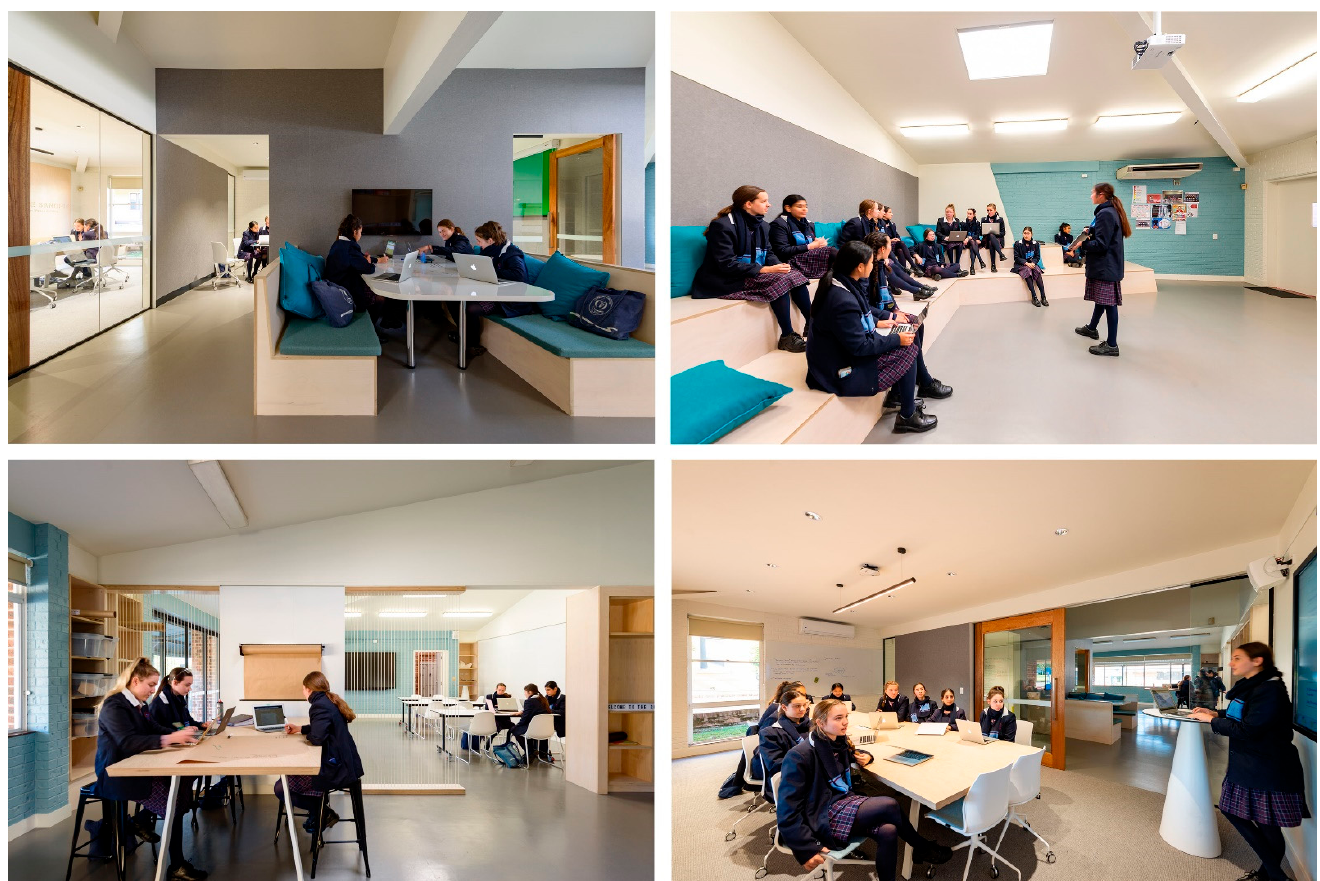
Figure 3. A range of settings to accommodate different teaching and learning modes, and activities (Images courtesy of Hayball architects).